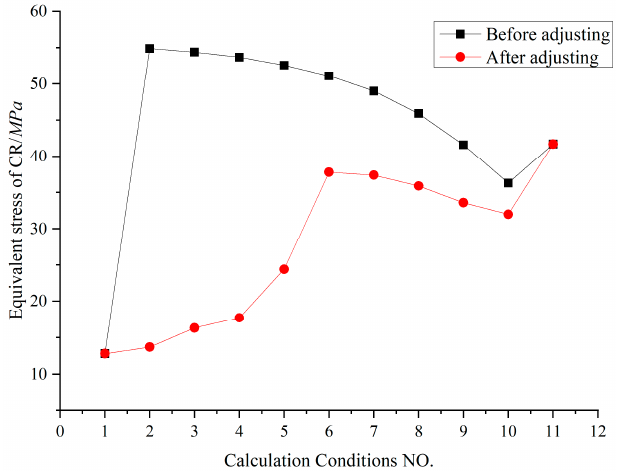
Figure 31. Maximum equivalent stress of CR before and after adjusting.